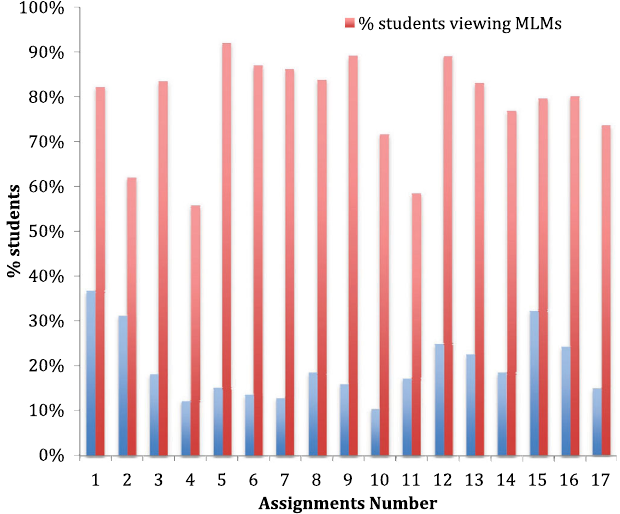
FIG. 3 (color online). Percentage of students who reported reading the textbook versus the percentage of students who viewed MLMs prior to